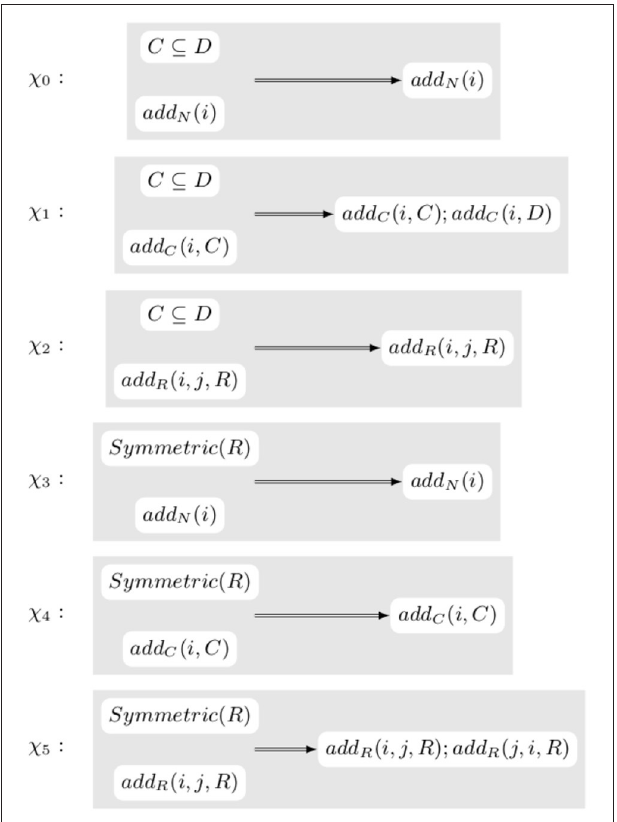
FIGURE 5 | Rules rewriting transformations depending on the form of the axioms in the ontology.